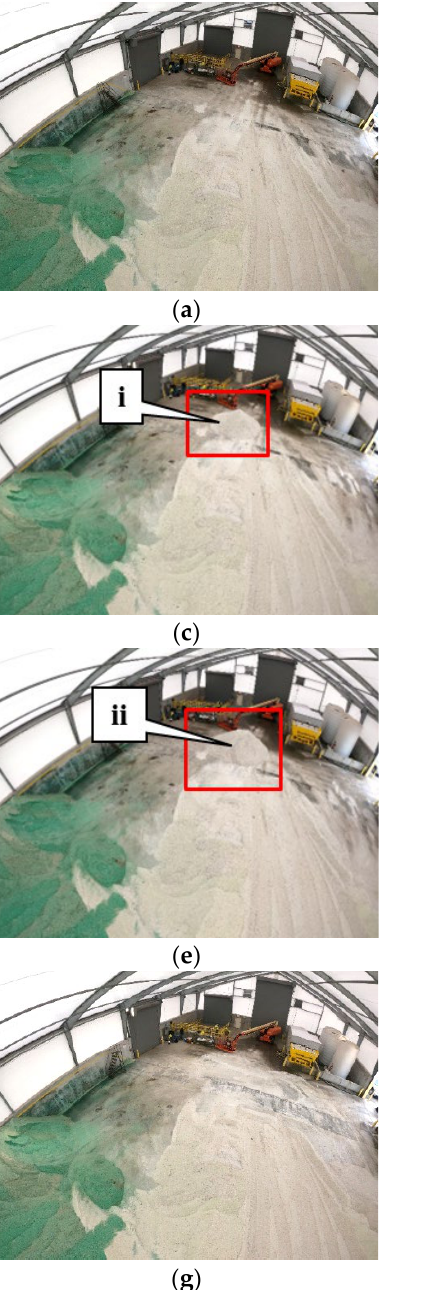
Figure 11. Data validation through salt repositioning ( a ) GoPro Image Before Salt Repositioning ( b ) Digital Surface Model Before Salt Repositioning ( c ) GoPro Image with 5 Buckets Repositioned ( d ) Digital Surface Model with 5 Buckets Repositioned ( e ) GoPro Image with 10 Buckets Repositioned ( f ) Digital Surface Model with 10 Buckets Repositioned ( g ) GoPro Image After Salt Repositioning ( h ) Digital Surface Model After Salt Repositioning.